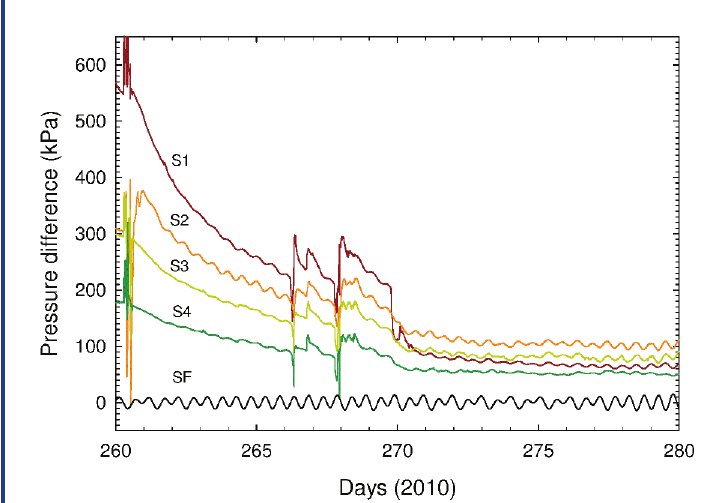
S2.Figure 6. Three-week record of the decay of screen pressures (relative to seafloor) following the ACORK installation at Hole U1364A. Absolute seafloor pressure is shown with the same scaling as the relative pressures at screens but with the mean seafloor pressure